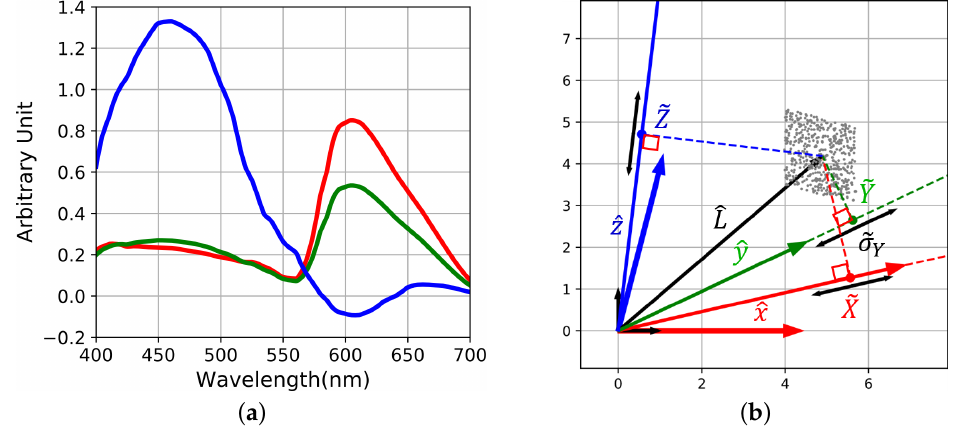
Figure 11. ( a ) Color matching functions projected into co-planar vectors (cid:98) x (cid:98) y (cid:98) z in sensor space, ( b ) corresponding geometry. Spectral noise is projected orthogonally on color matching axes giving (cid:101) X (cid:101) Y (cid:101) Z and corresponding variances onto color matching channels.